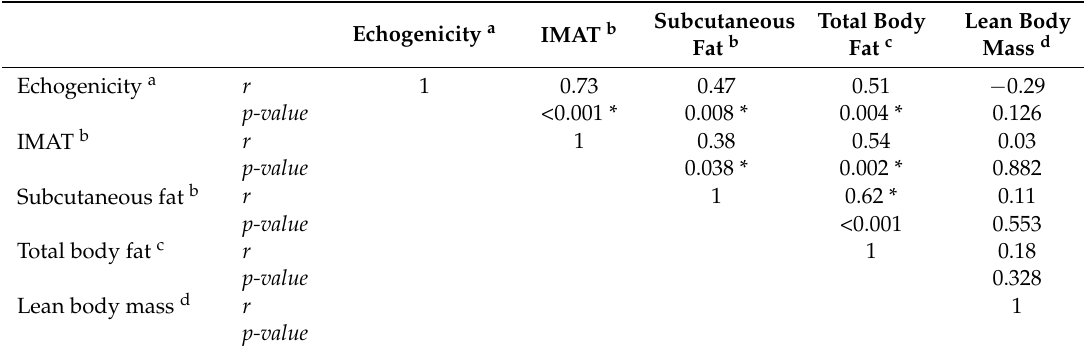
Table 2. Associations among surrogate measures of muscle quality and body composition